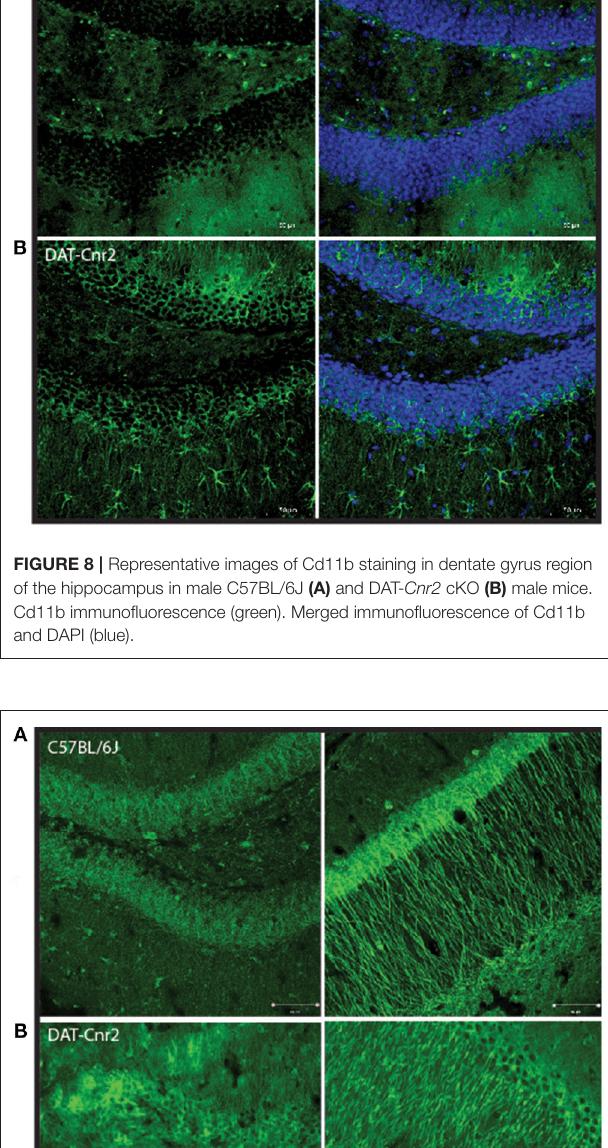
amphetamine treatment in the DAT- Cnr2 mice. This